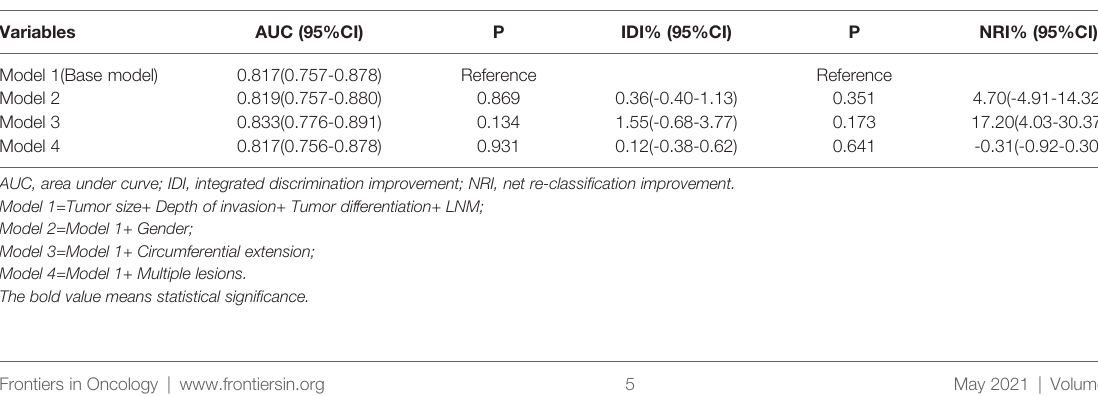
TABLE 4 | Comparison of different prediction model for estimating the risk of LVI presence. Variables